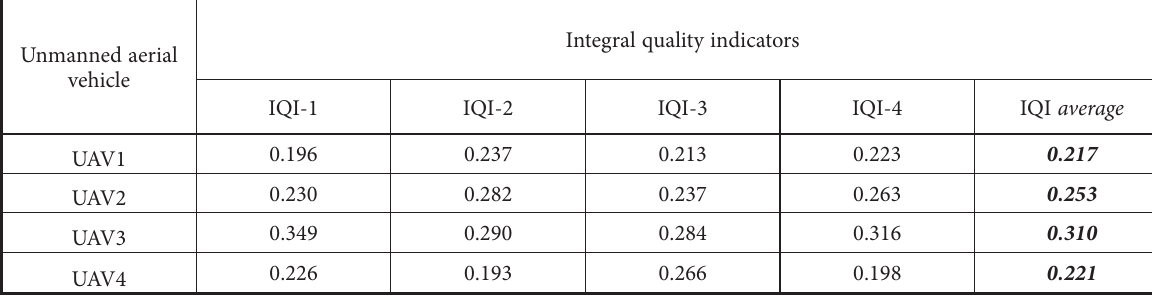
Table 16. Priorities of UAVs according to their integral quality indicators